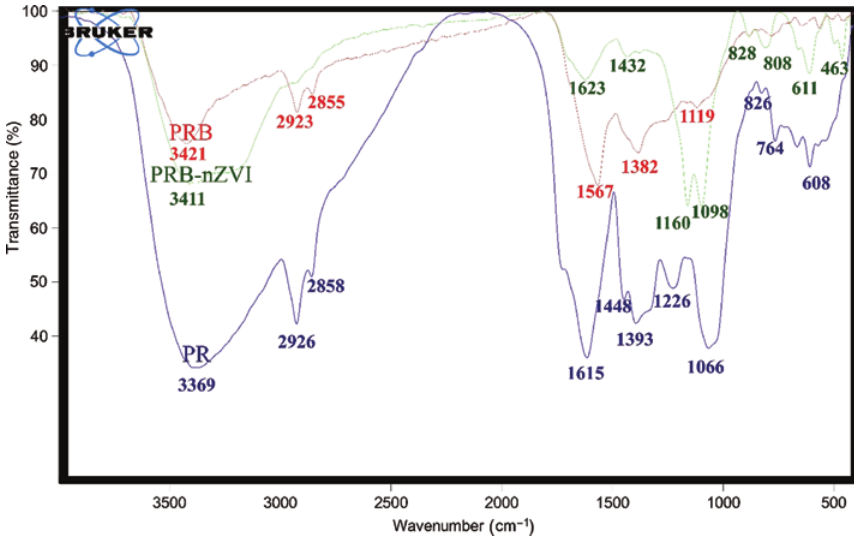
Figure 1: FTIR spectra of PR, PRB, and PRB-nZVI.